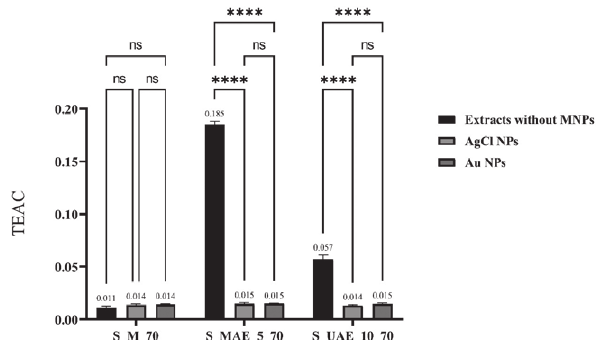
Figure 6. Trolox equivalent antioxidant capacity of simple extract and nanostructured phytochemical complexes of S. officinalis (Data are expressed as mean ± SD values from independent triplicate experiments and p values were calculated by one-way ANOVA fol- lowed by Šídák’s multiple comparisons test; ****p < 0.0001; ns p =